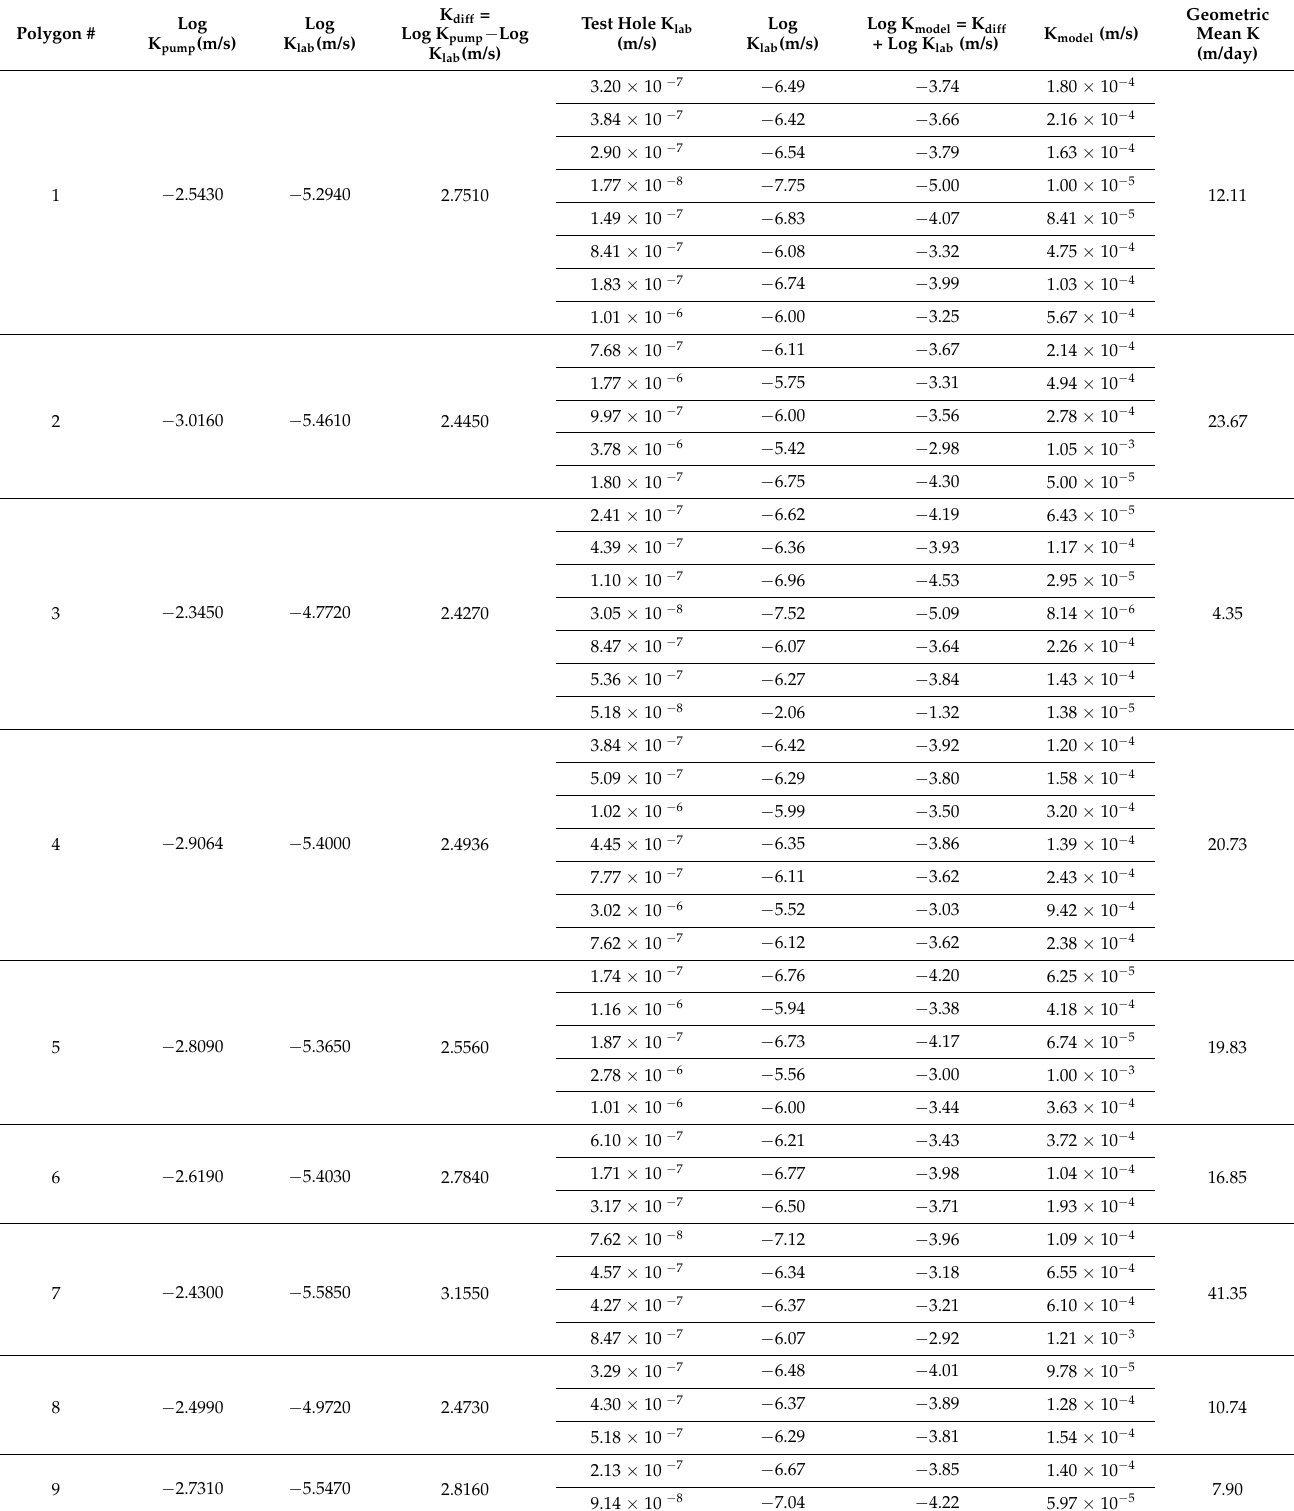
Table 3. Methodology used for computing the final value of hydraulic